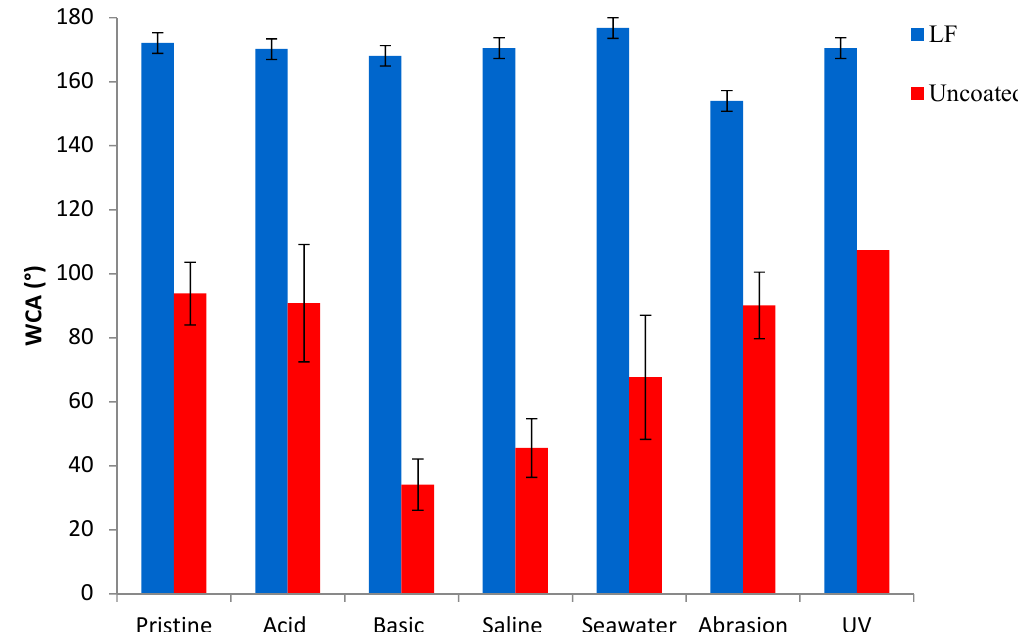
Figure 7. Water contact angle (WCA) of uncoated (in red) and LF (in blue) samples before (“pristine”) and after ageing tests.